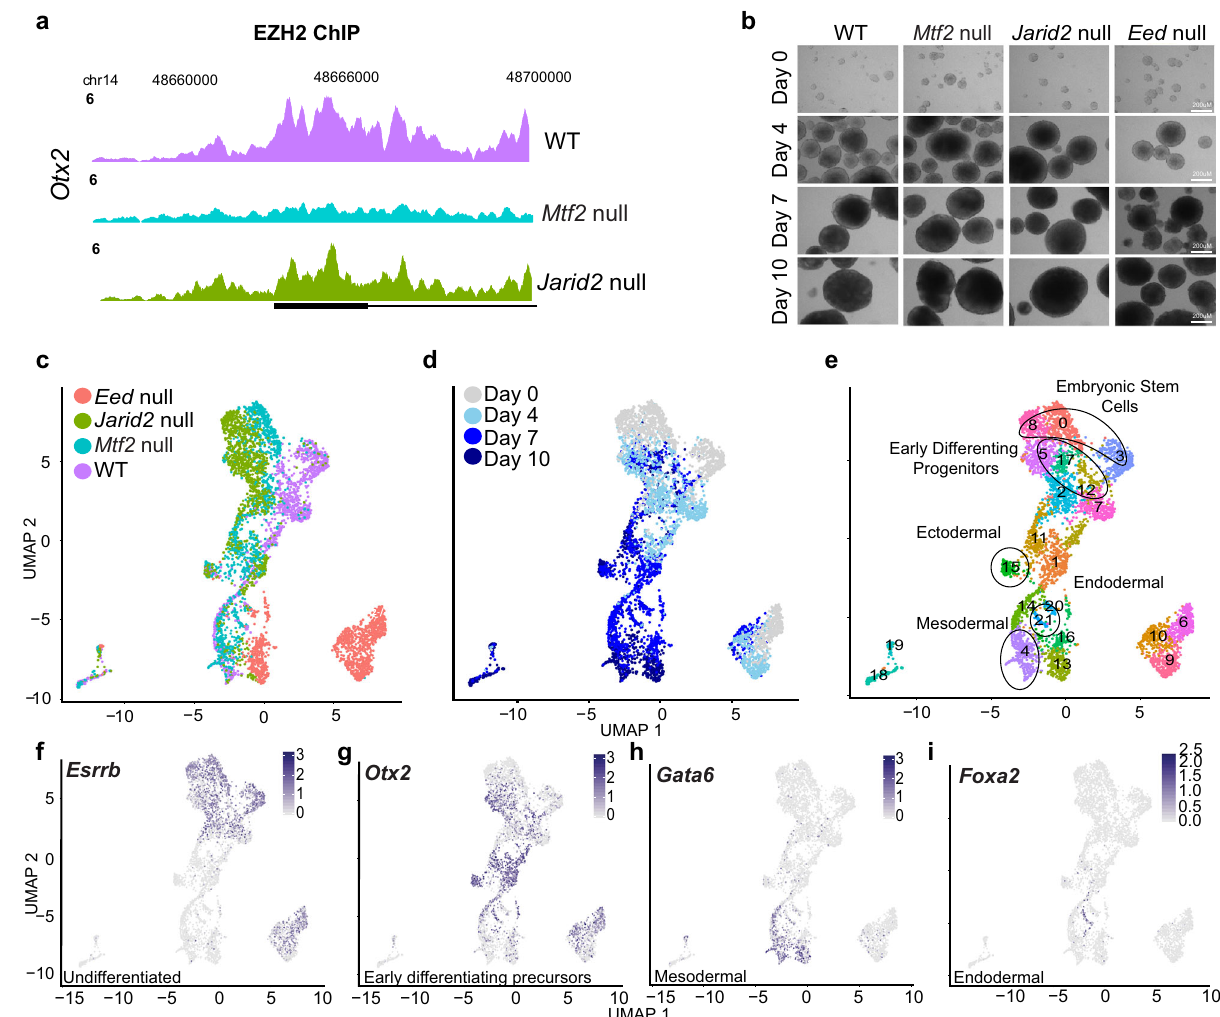
Fig. 1 Embryoid bodies of PRC2 mutant ESCs yield a multitude of cell types across different germ layers. a EZH2 ChIP peak pro fi les of gene Otx2 for WT, Mtf2 null, and Jarid2 null cells. Peaks were RPKM normalized and scaled across backgrounds. b Phase-contrast of Embryoid Bodies from different background and time point of differentiation. Each differentiation time point and background were performed in replicates. c , d Single-cell UMAPs of 4949 cells over all backgrounds and time points. e Single-cell UMAP of cells colored by predicted clusters. f – i Feature maps of selected lineage genes, color intensity based on normalized expression of individual